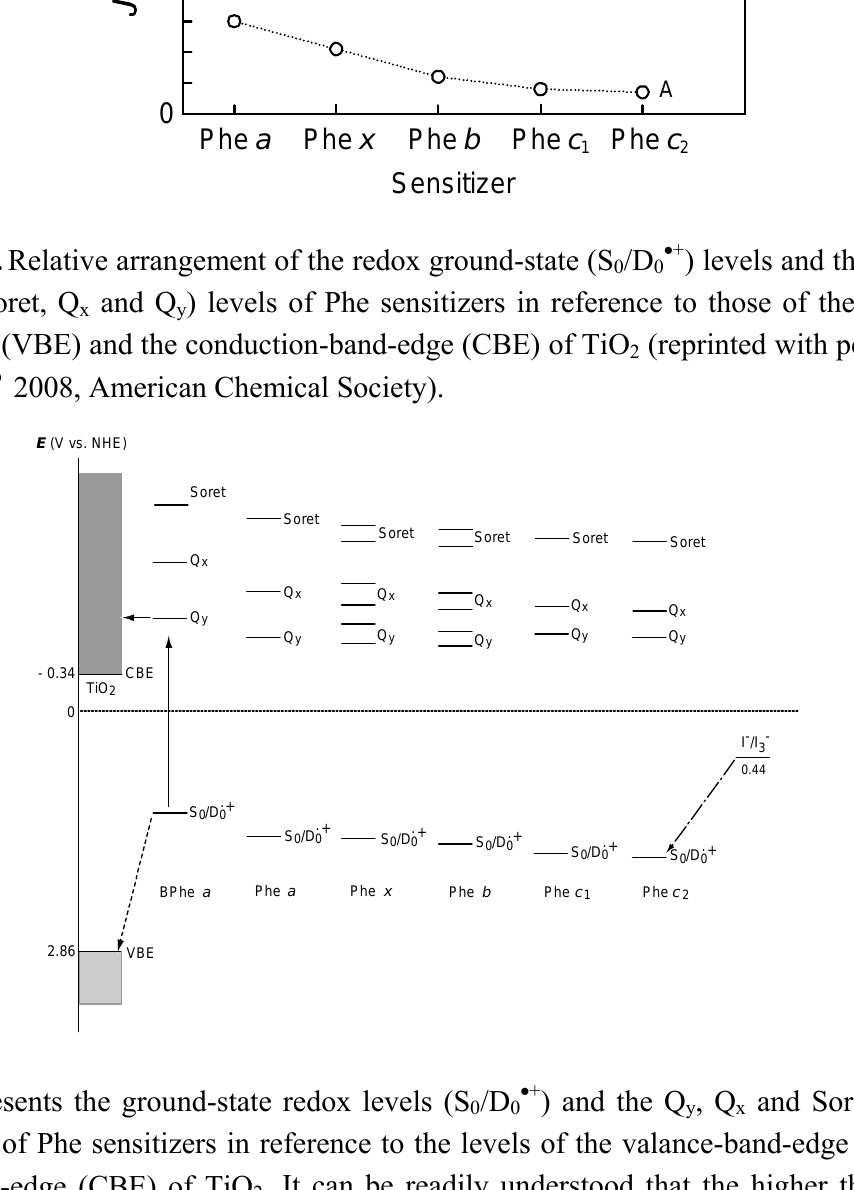
Figure 38. A graphical presentation of the results of fitting to Equation (3) (reprinted with permission from [20] © 2008, American Chemical Society).